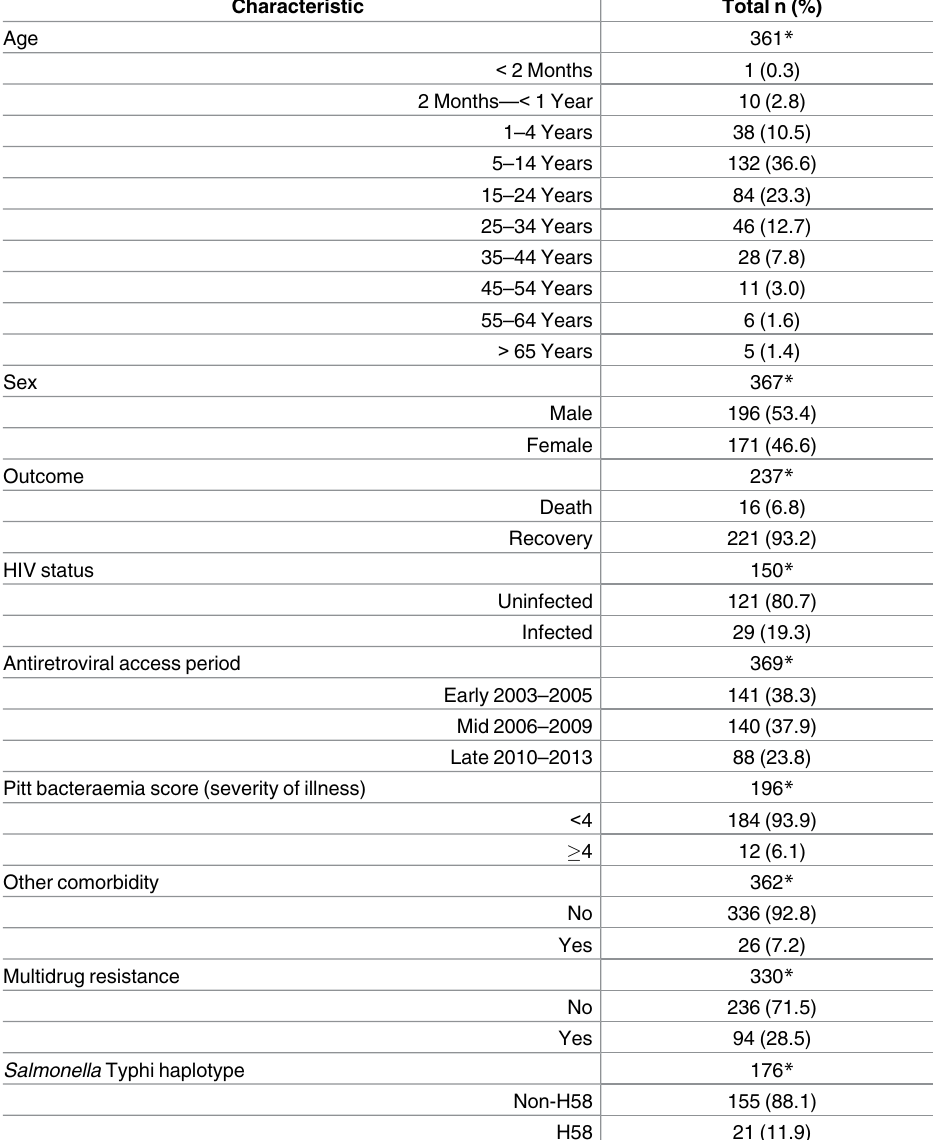
Table 2. Clinical and laboratory characteristics associated with patients with culture-confirmed typhoid fever in South Africa (N = 369), 2003–2013, based on data from sentinel sites. Characteristic Total n (%) Age 361